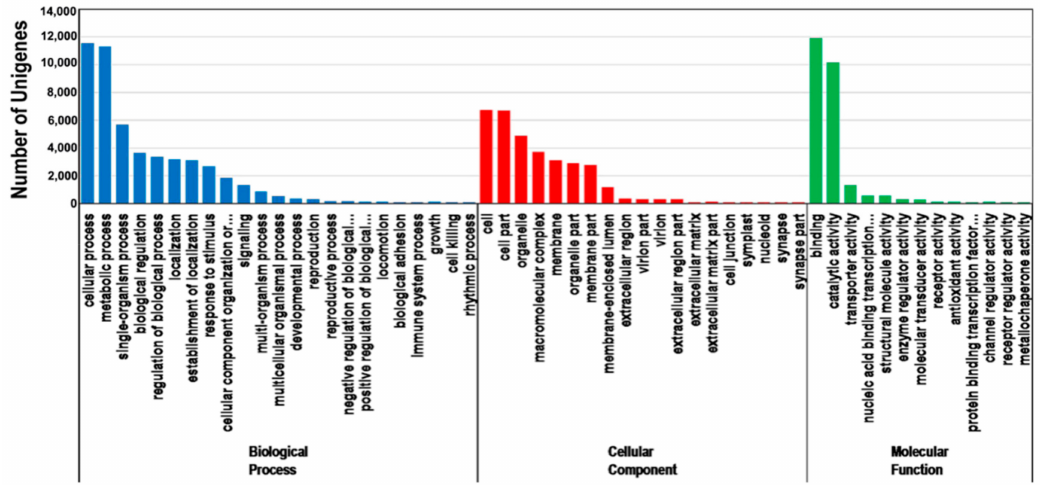
Figure 3. Gene Ontology (GO) classifications of the assembled unigenes. The main functional annotations in the biological process, cellular component, and molecular function categories are presented. Bars represent the number of Platycladus orientalis proteins with BLASTX matches to each GO term. One unigene may be matched to multiple GO terms.